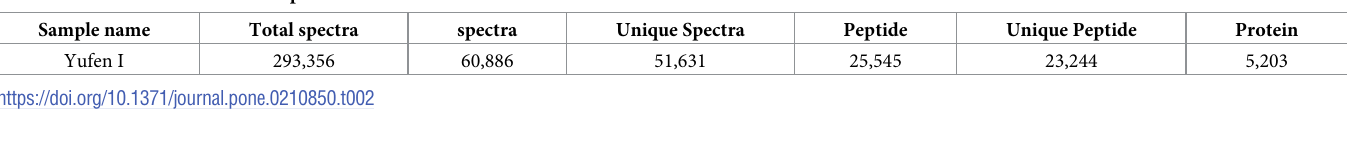
Table 2. Information on identified proteins in chicken feather